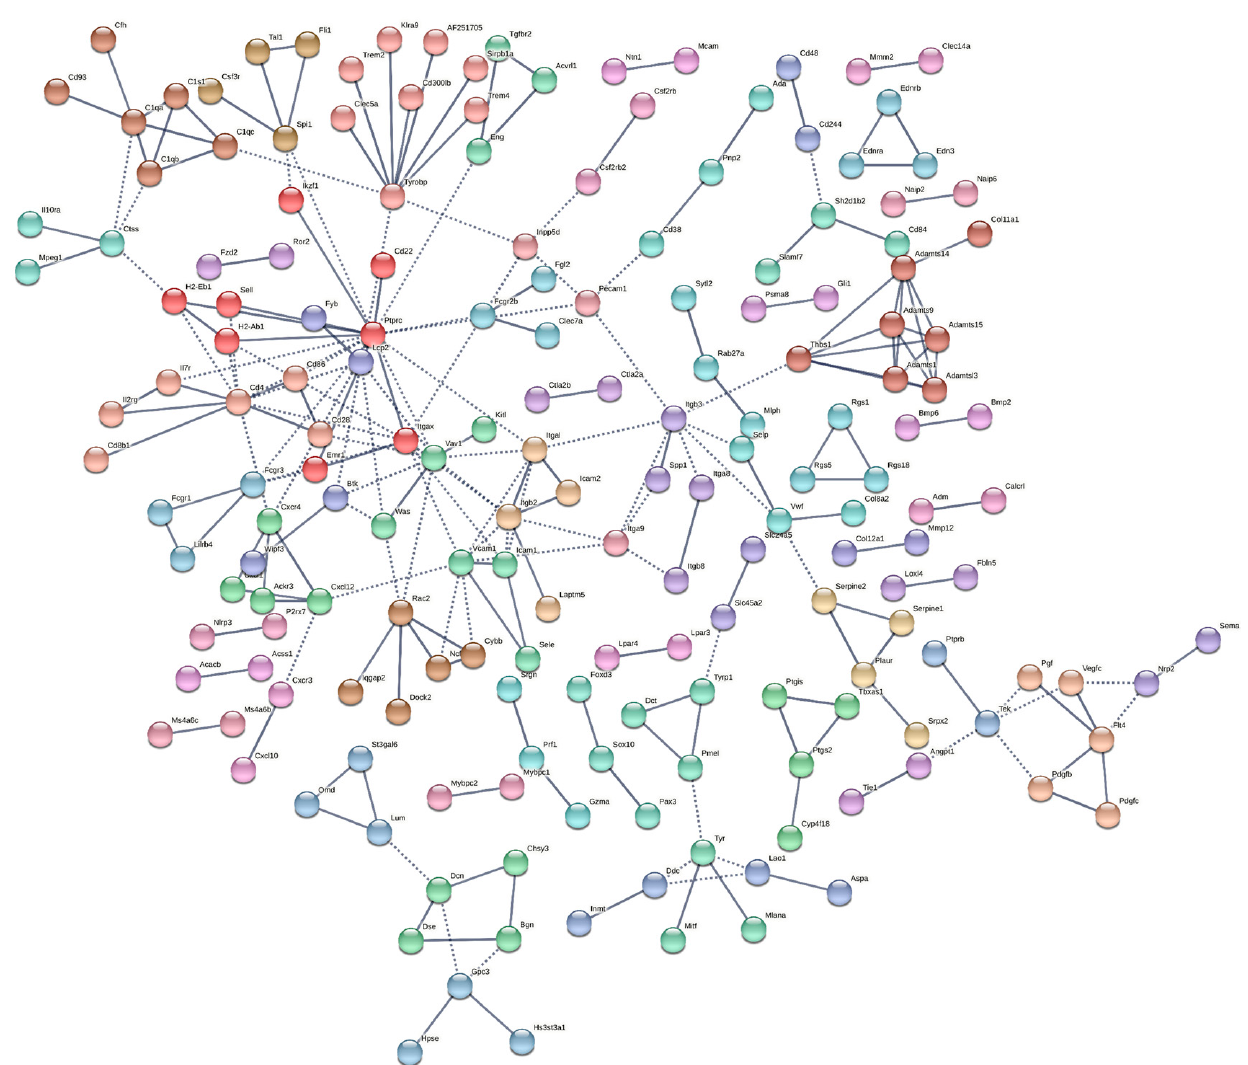
Figure 4. STRING network of protein–protein interaction (PPI) generated using identified DEGs (FDR < 0.05, log 2 FC > 2). Network was generated using STRING version 11.5. Table 1. Top 10 Hub Genes (Score) in STRING Network Analysis by Methodology.